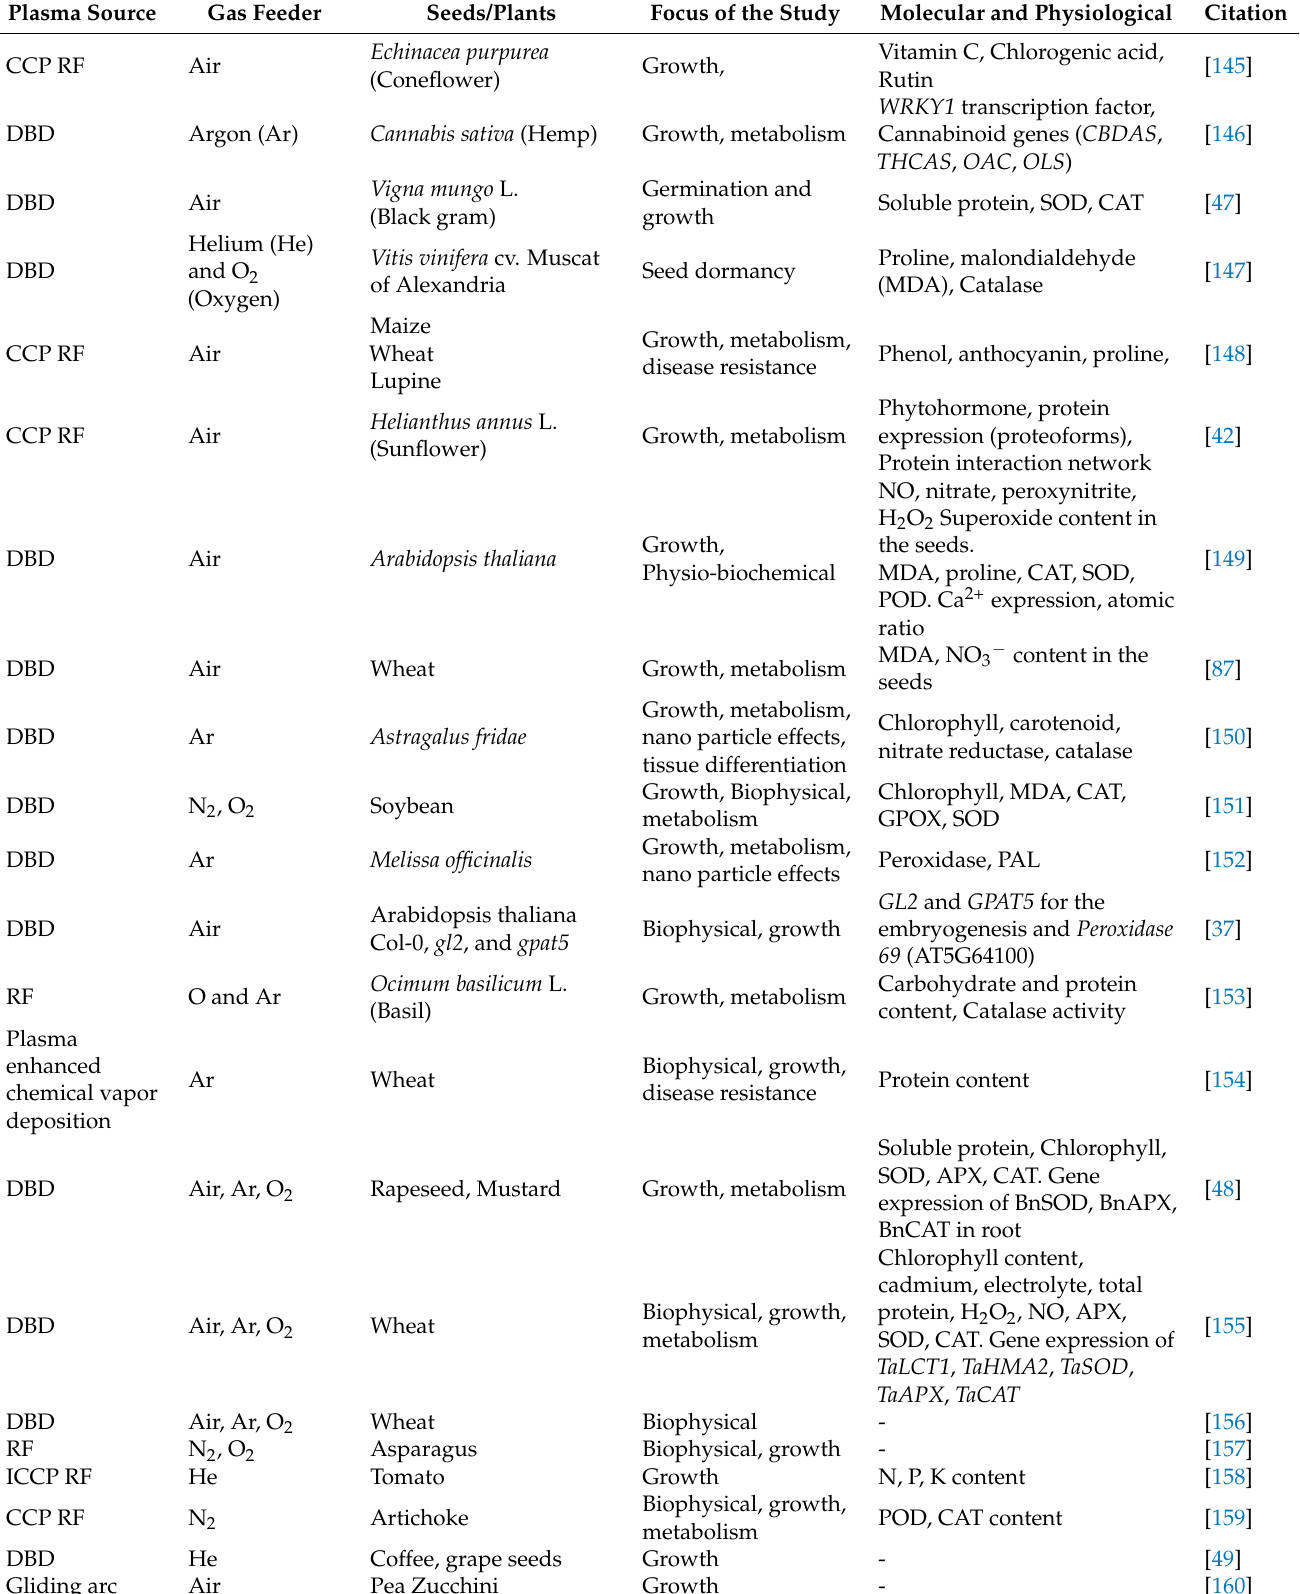
Table 1. Studies on plasma treatment in seeds/plants of different plants species using various plasma